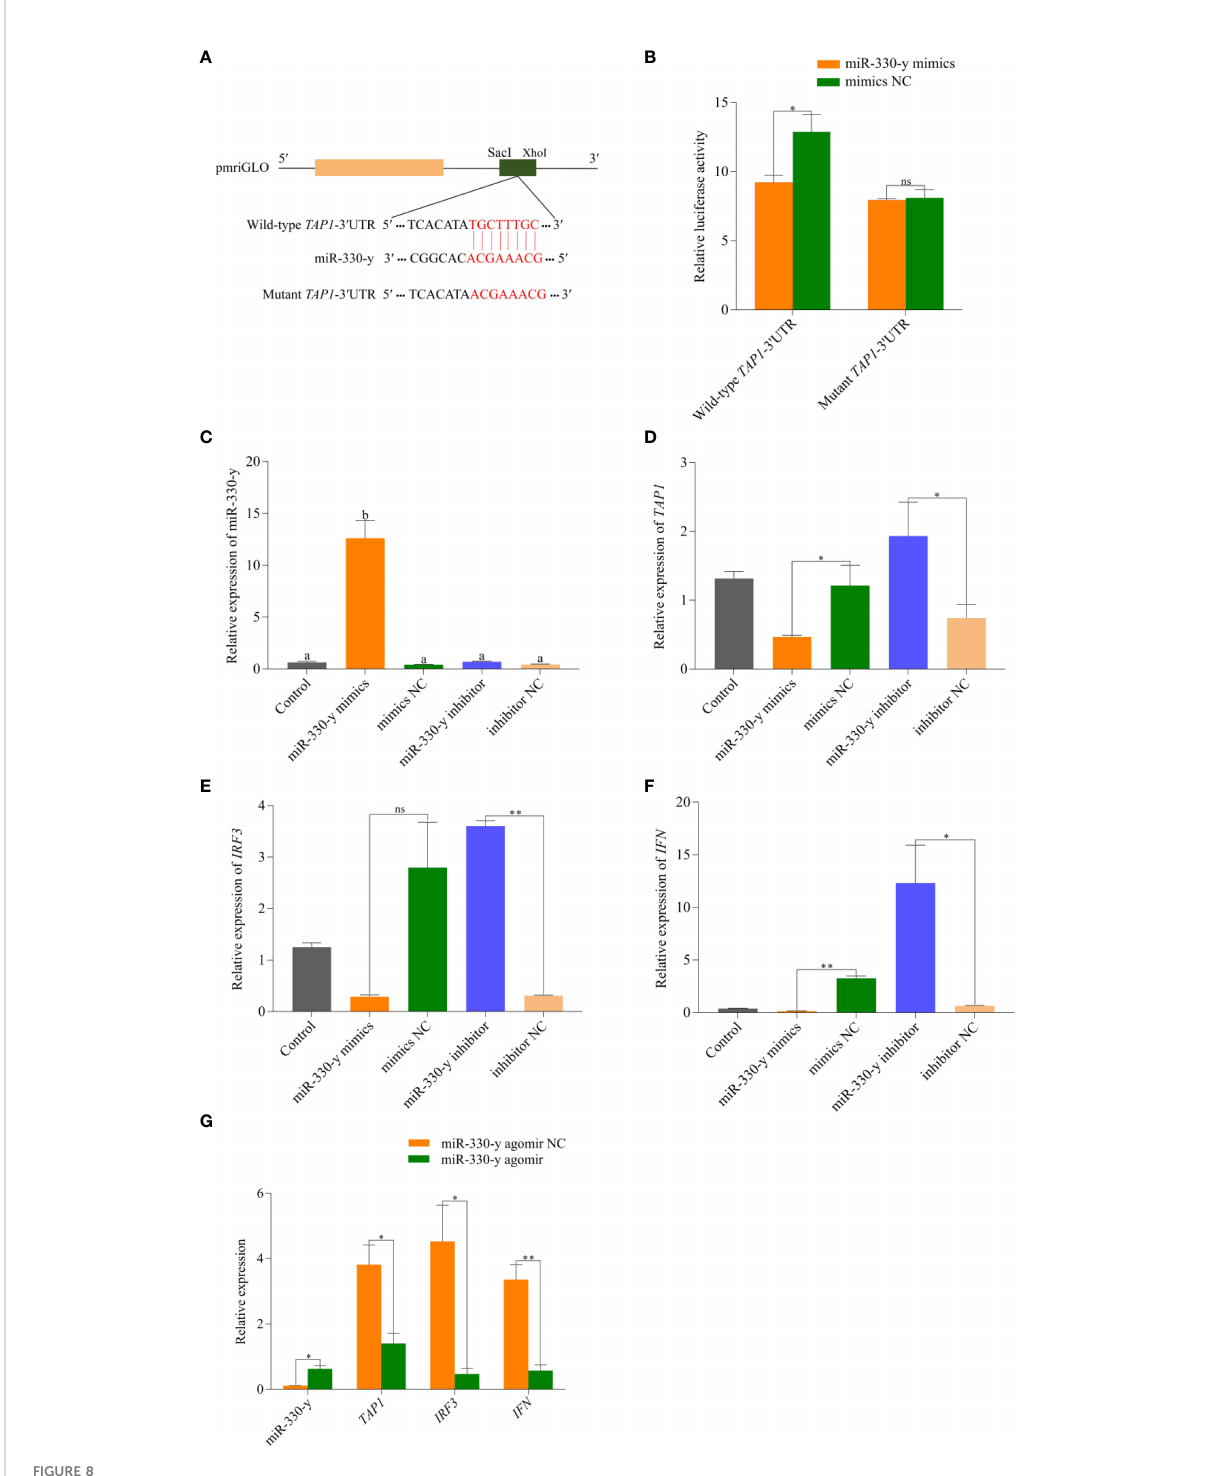
FIGURE 8 Functional validation of miR-330-y targeting TAP1 in vitro and in vivo . (A) The TAP1 -3 ′ UTR sequence was inserted into the pmriGLO vector to construct the wild-type and mutant dual luciferase reporter plasmids, respectively. (B) The results of dual luciferase reporter assay. (C) miR-330- y, (D) TAP1 , (E) IRF3 , (F) IFN expression levels in rainbow trout liver cells after transfected with miR-330-y mimics or miR-330 inhibitor. (G) Effects of miR-330-y agomir on expression of miR-330-y, TAP1 , IRF3 , and IFN in vivo . The different lowercase letters above the bars indicate signi fi cant differences (P < 0.05); *P < 0.05, **P < 0.01; ns, represents no signi fi cant difference (P >